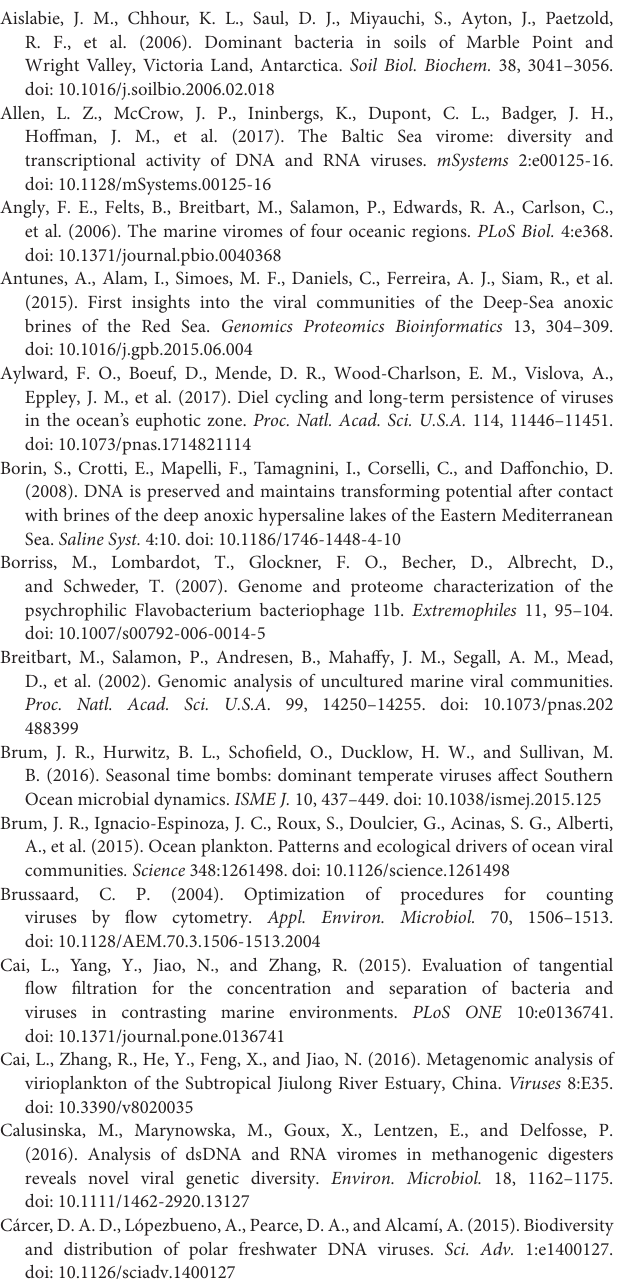
Table S1 | Taxonomic viral composition based on LCA affiliation for viral contigs via MetaVir2. Relative quantities expressed as DNA-RPKM numbers and percentage. Table S2 | Specific viral composition based on host taxonomies. Relative quantities expressed as percentage. Table S3 | Detailed information of selected environmental DNA viromes available on